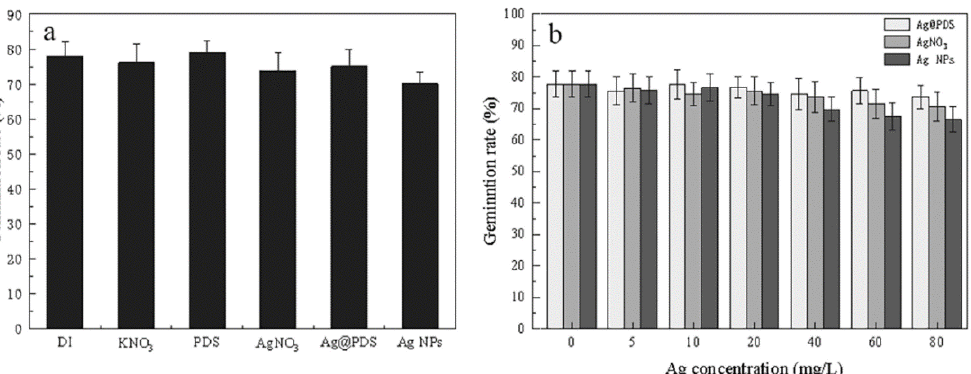
Figure 2. Germination rate of L. multiflorum seeds in control and Ag@PDS, AgNO 3 , and AgNP treatments. Equivalent control condition of DI, KNO 3 , PDS, and 40 mg/L Ag concentration of Ag@PDS, AgNO 3 , and AgNPs ( a ); different Ag concentrations of Ag@PDS, AgNO 3 , and AgNPs ( p ≤ 0.05) ( b ).